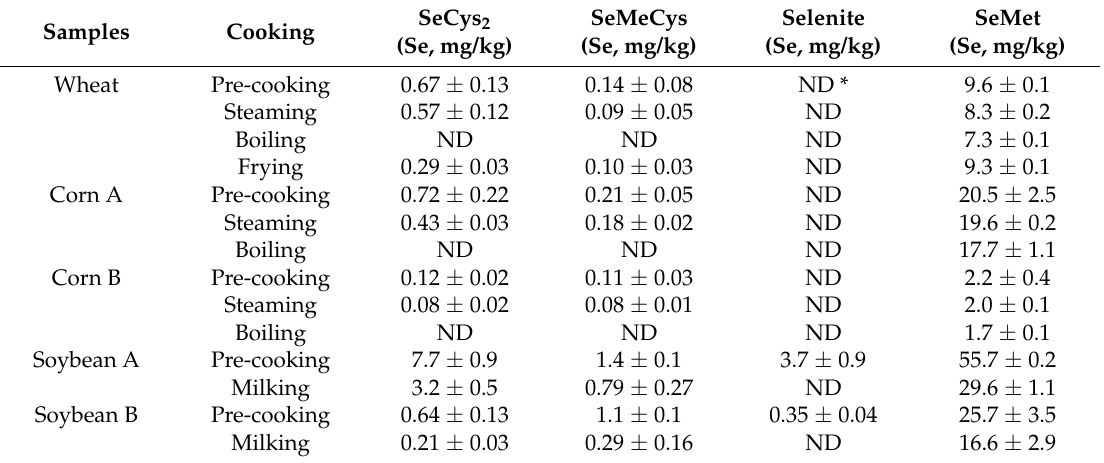
Table 4. Selenium species concentration of pre-cooking and cooked cereals and